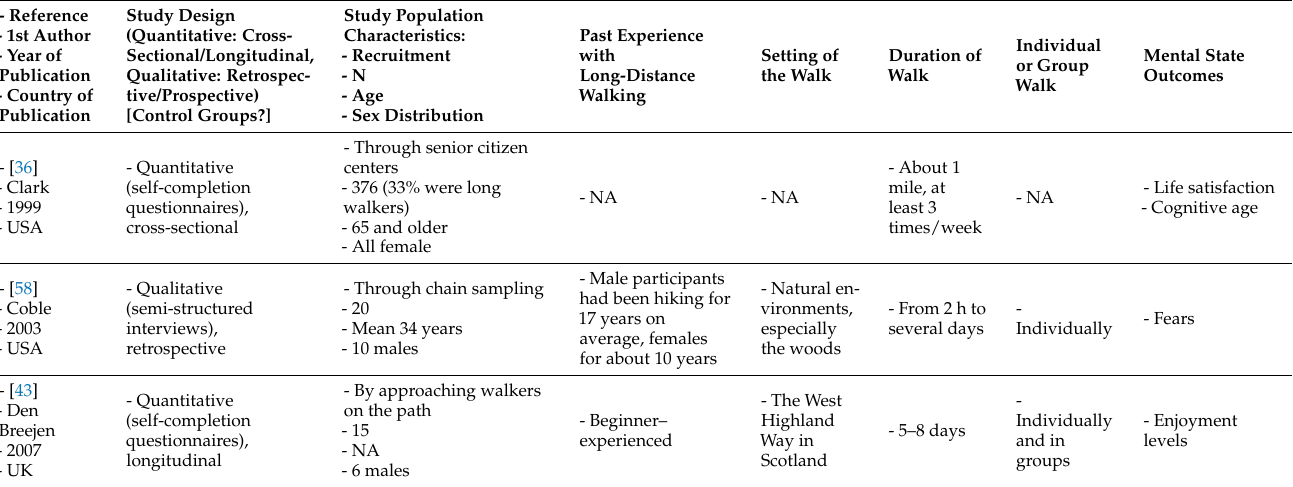
Table A1. Overview of study